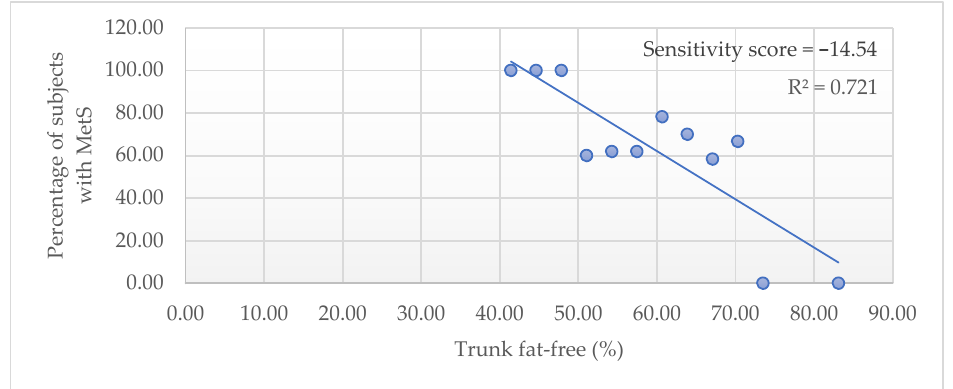
Figure 2. Distribution and prevalence charts for Trunk fat ‐ free (%).